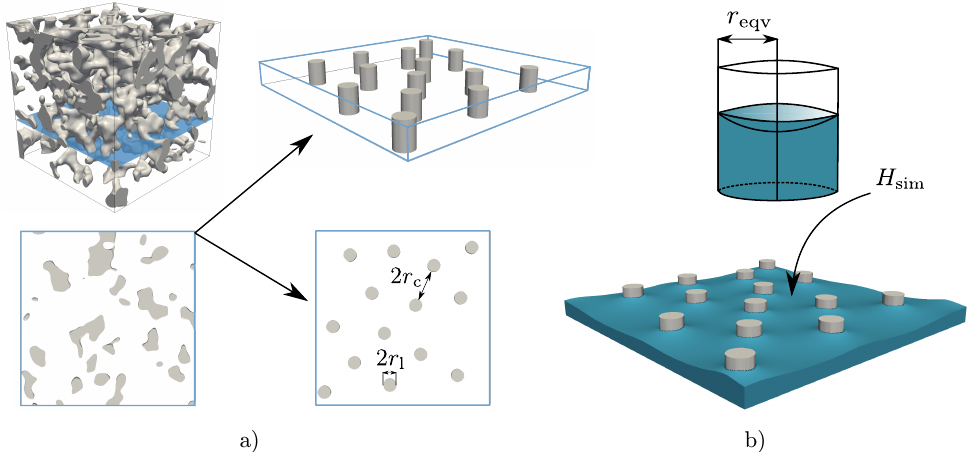
Figure 6. ( a ) Section of a complex membrane of the computer tomography data and the simplified model for the derivation of a correction function. ( b ) Schematic representation of the derivation of the equivalent radius r eqv , based on the simulated mean curvature H sim (adapted from